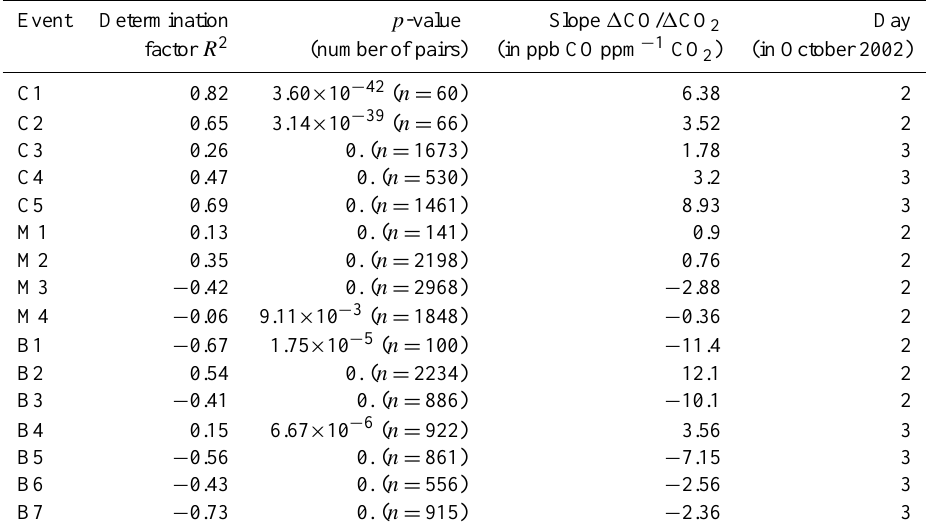
Table 5. Evaluation of the correlation level between CO 2 and CO for the different events selected from Fig. 7. Each event has been attributed to a class according to its back-trajectory location and direction (from Fig. 6) as explained in the text.